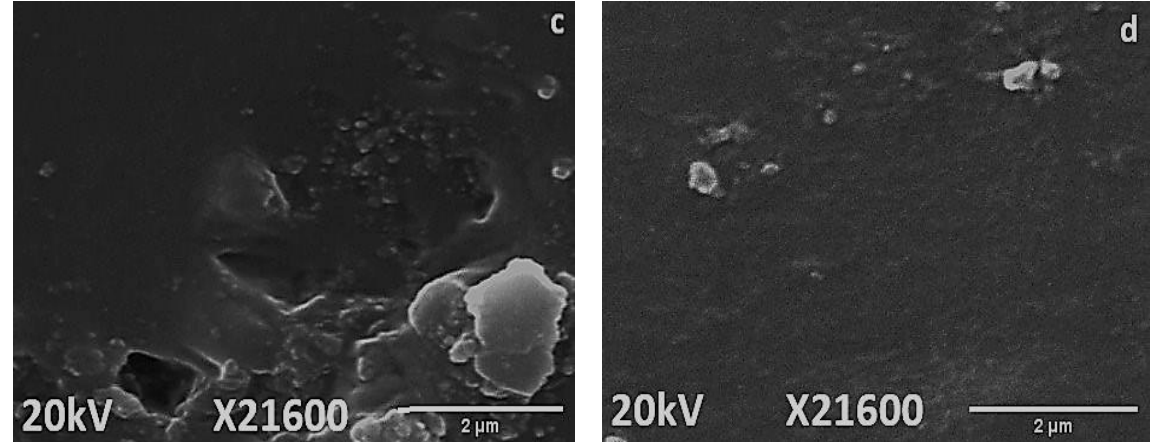
Figure 11. SEM images of 1000 h aged ( a ) nSiR ( b ) SMC 15 ( c ) SNC 2.5 and ( d ) SNC 5.